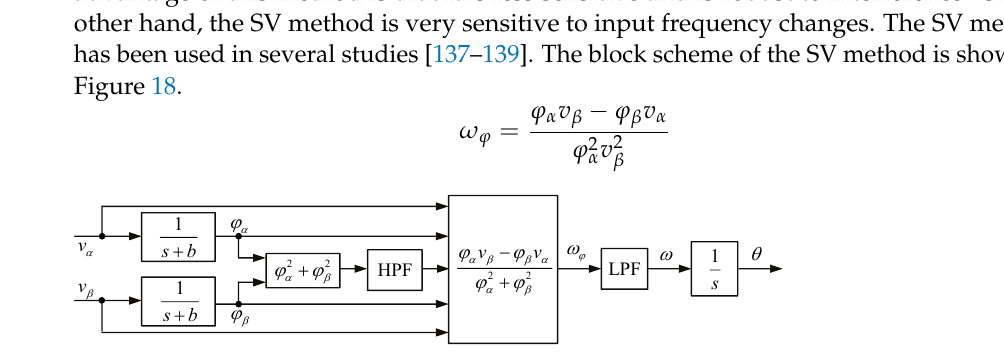
Figure 18. Space vector method.